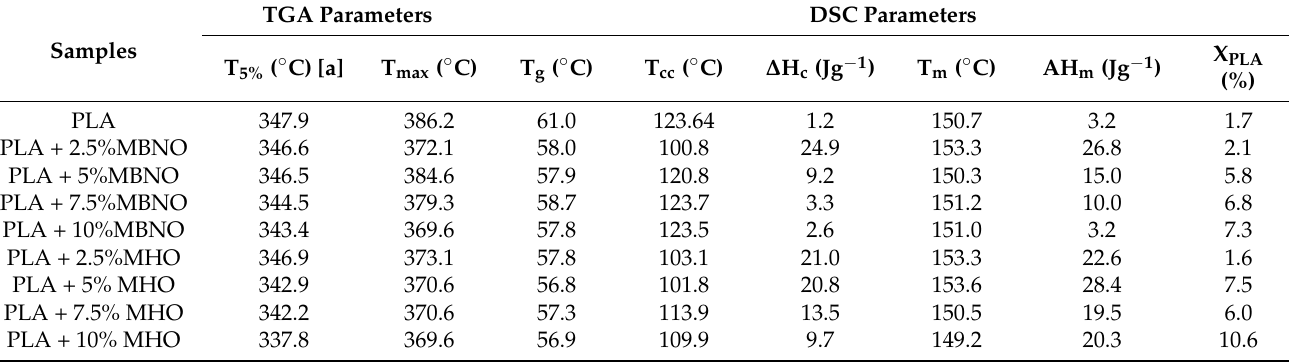
Table 2. Summary of the TGA and DSC thermal parameters of PLA unplasticized and plasticized with different amounts of MBNO and MHO